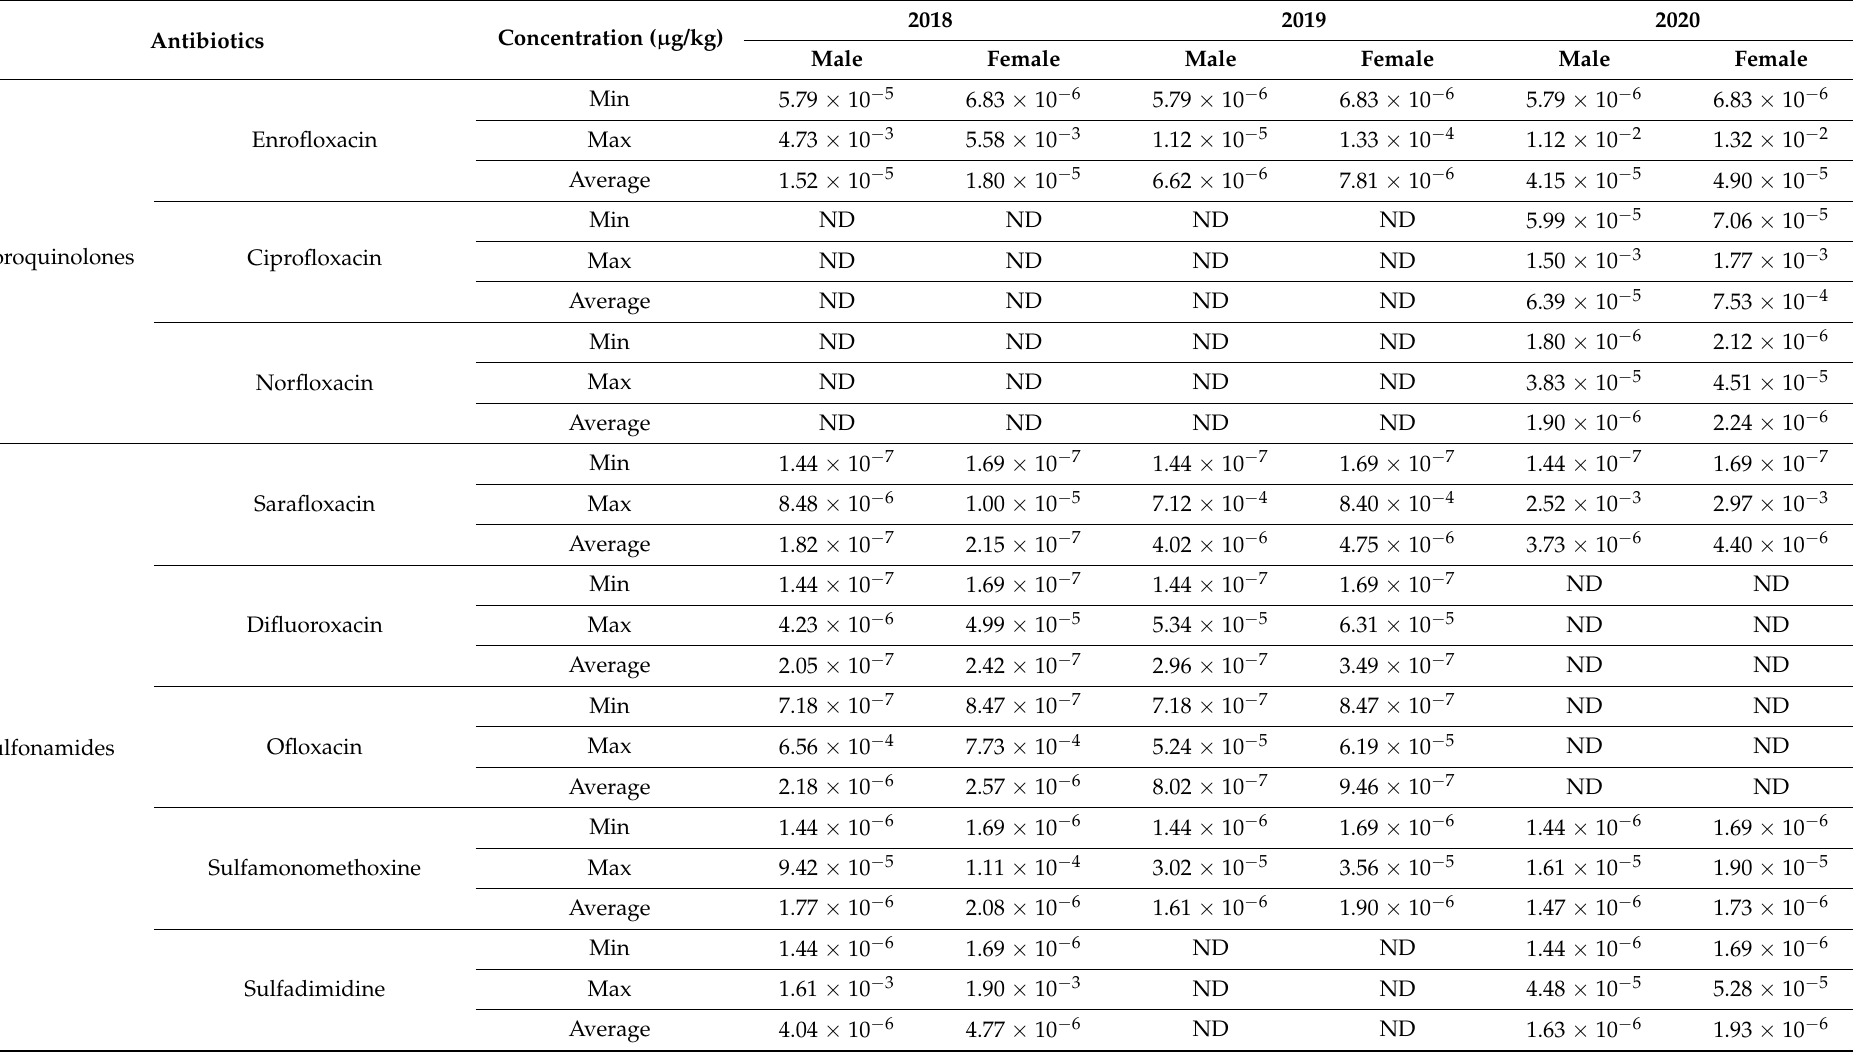
Table 6. International Food Safety indices (IFS) of poultry eggs in Shandong, 2018–2020 (average intake of eggs, 25 g/d/person).